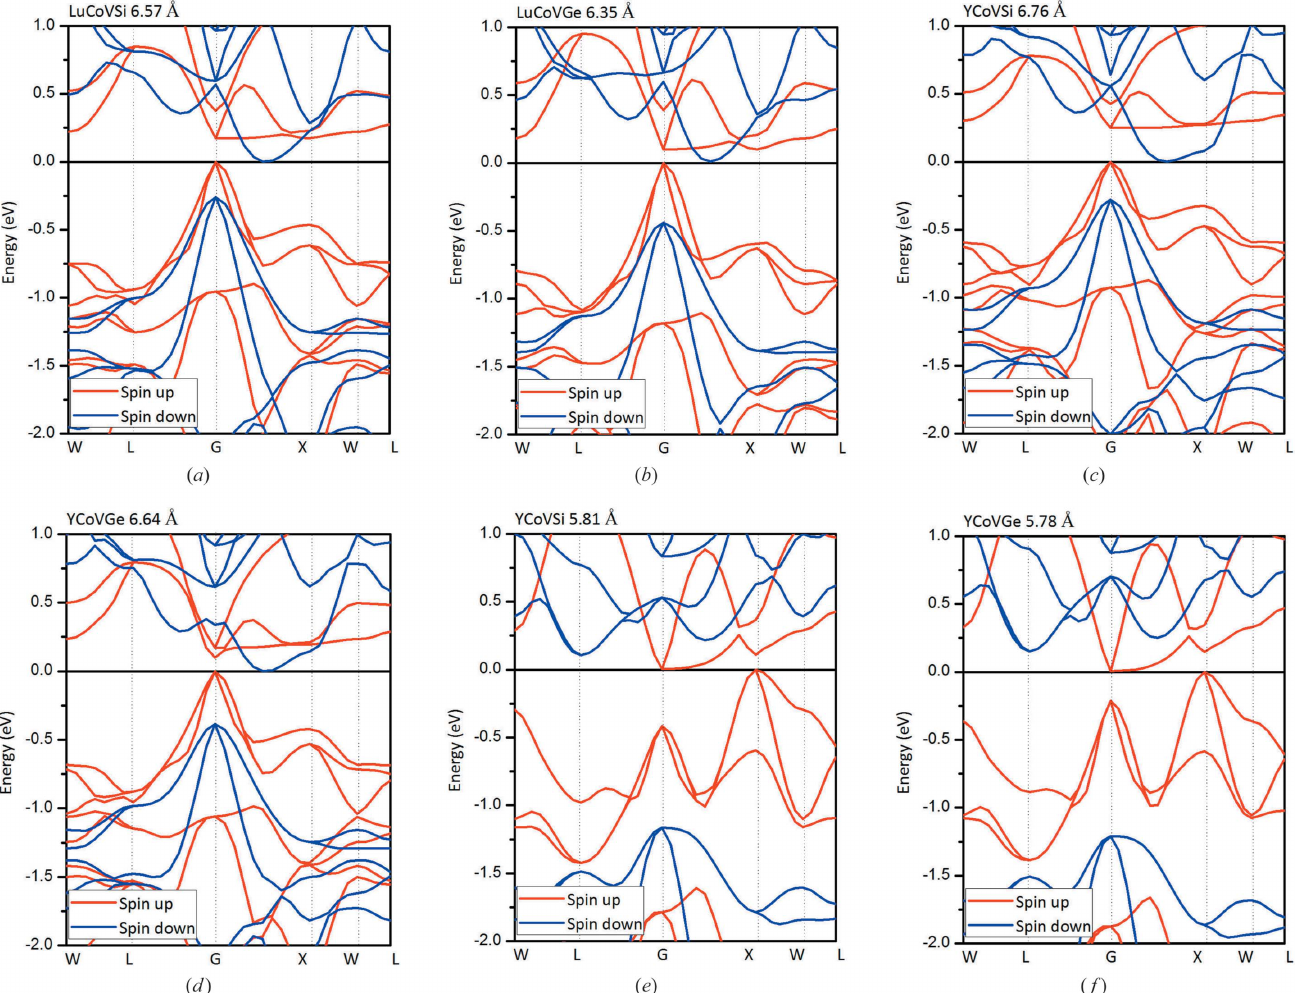
Figure 8 Calculated band structures for the rare earth-containing EQH compounds ( a ) LuCoVSi, ( b ) LuCoVGe, ( c ), ( e ) YCoVSi and ( d ), ( f ) YCoVGe at their strained lattice constants. Different types of spin-gapless behaviour can be clearly observed for these